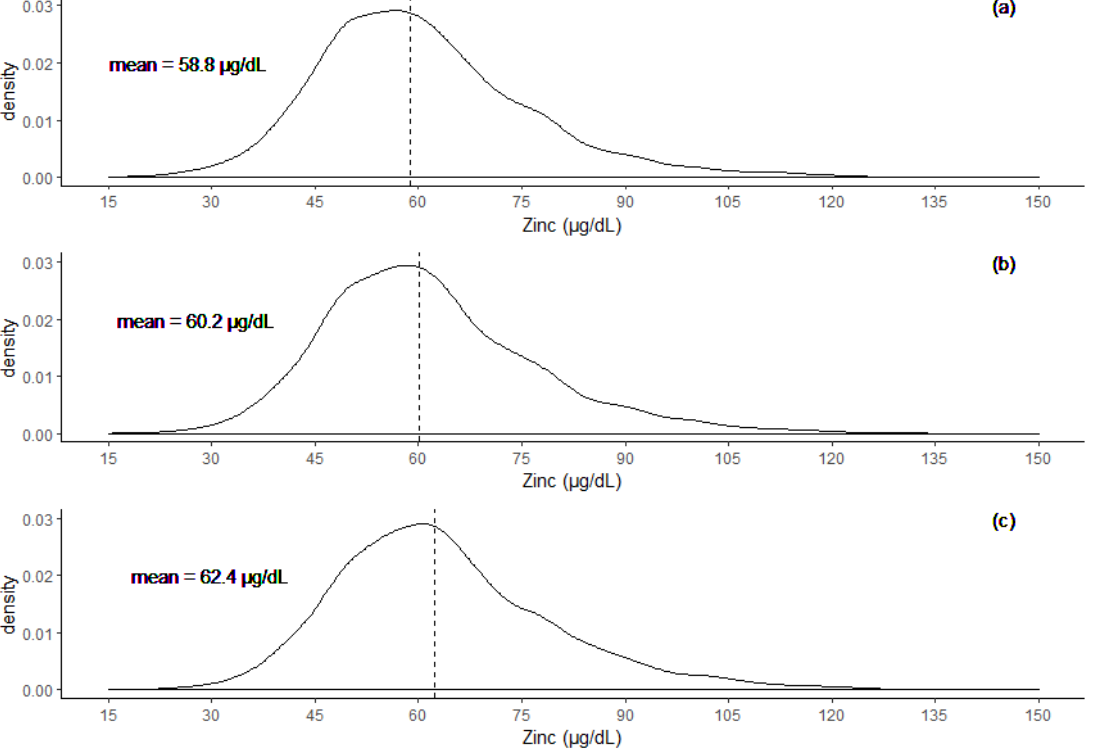
method, and ( c ) after adjusting with BRINDA method. Dashed lines correspond to mean values.